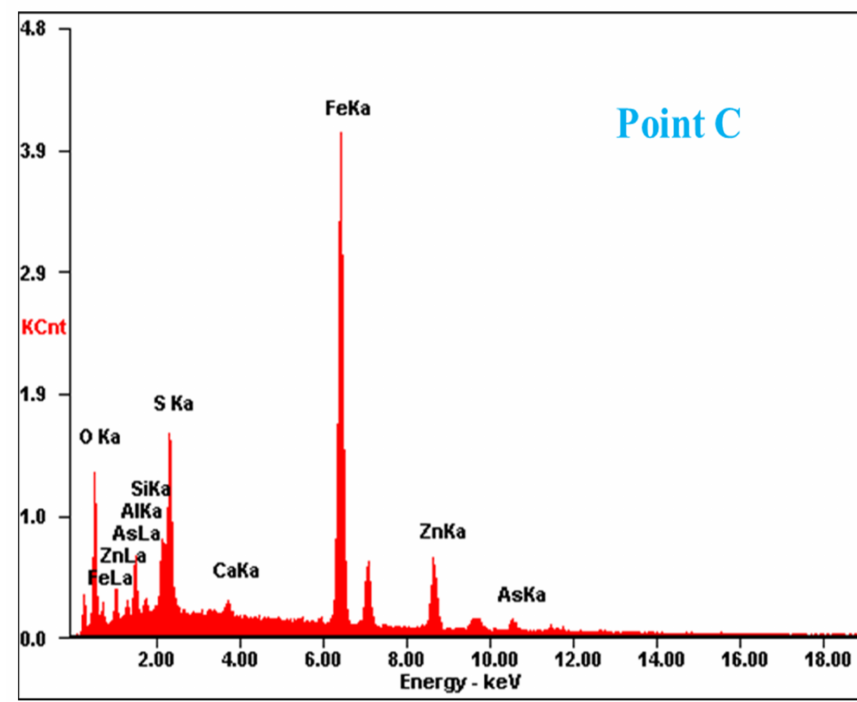
Figure 2. SEM image and EDS point analysis of the raw ZOD sample.